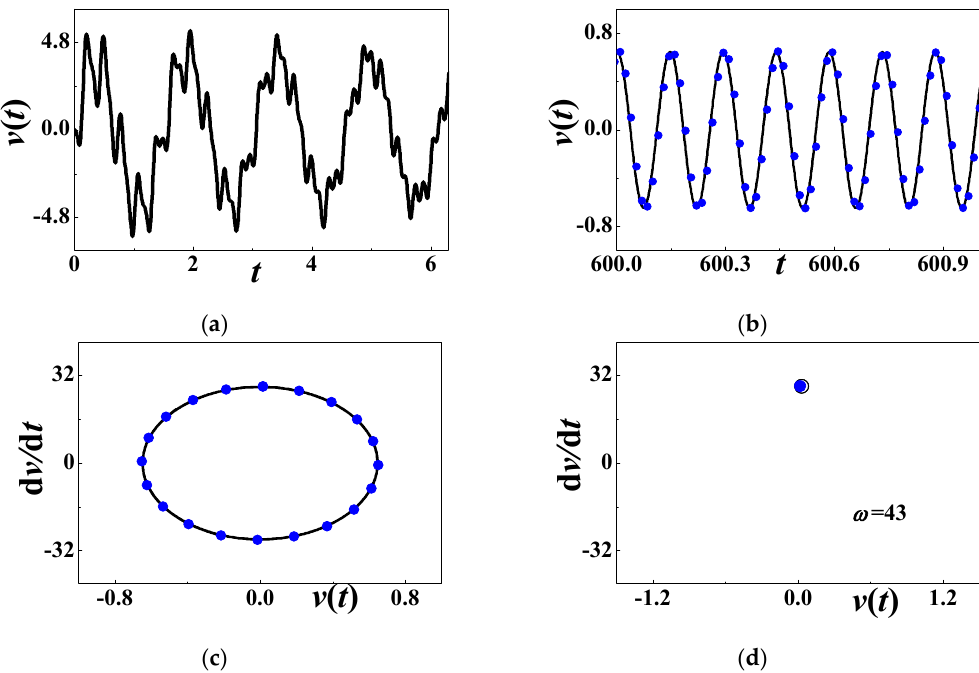
Figure 11. The periodic response when ω = 43: ( a ) initial history; ( b ) steady-state response; ( c ) phase diagram; ( d ) Poincare map. The solid blue dots stand for analytical prediction and others for numerical simulation.